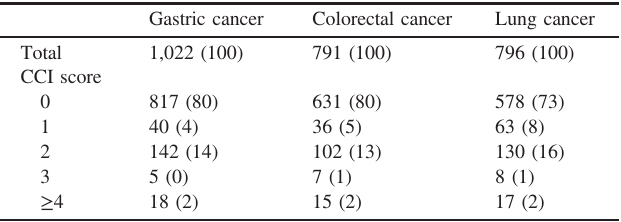
Table 4. Assessment of Cox proportional hazards models